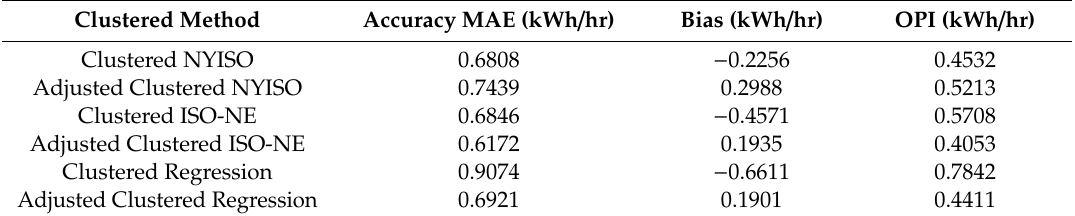
Table 6. Accuracy, bias and overall performance index (OPI) for clustered methods at event hours.